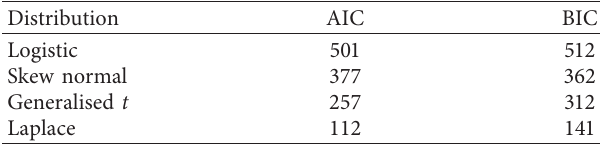
Table 6: Marginal distribution of our inflation rate residuals. Distribution